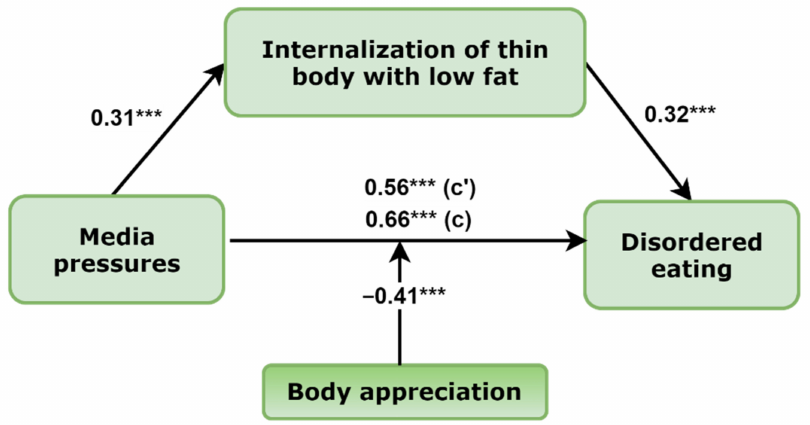
Figure 5. The final moderated mediation model in boys with the mediating effect of internalization of thin body ( n = 570). Note: standardized path coefficients are presented; c’ = direct effect, c = total effect; *** p < 0.001.